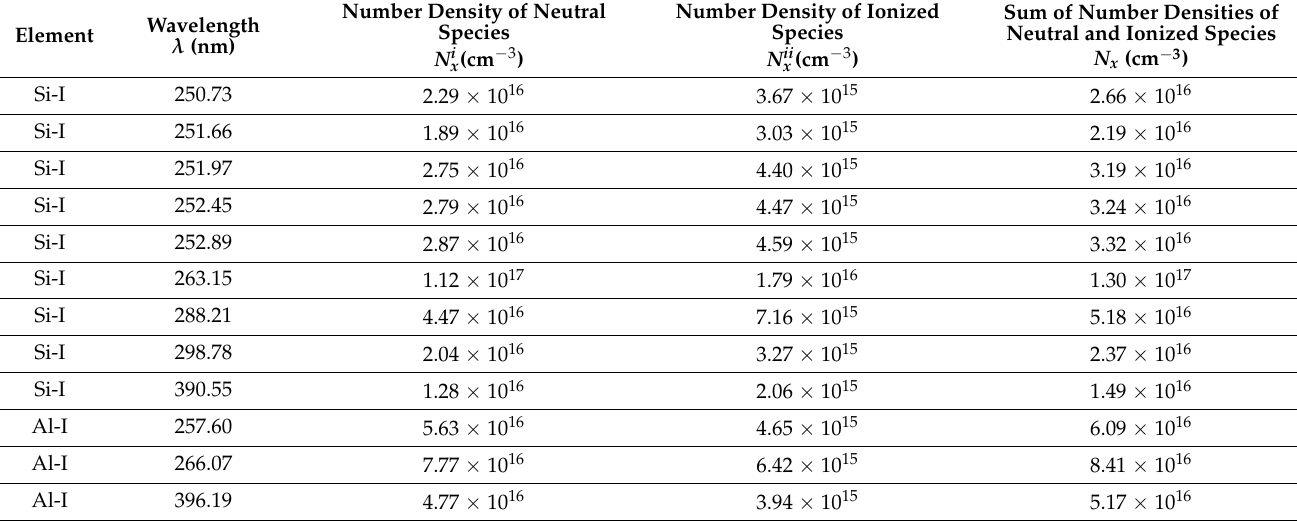
Table 4. Atomic number densities of neutral and ionized species of topaz crystals at a plasma temperature of 12,660 ± 633 K. Wavelength Element λ